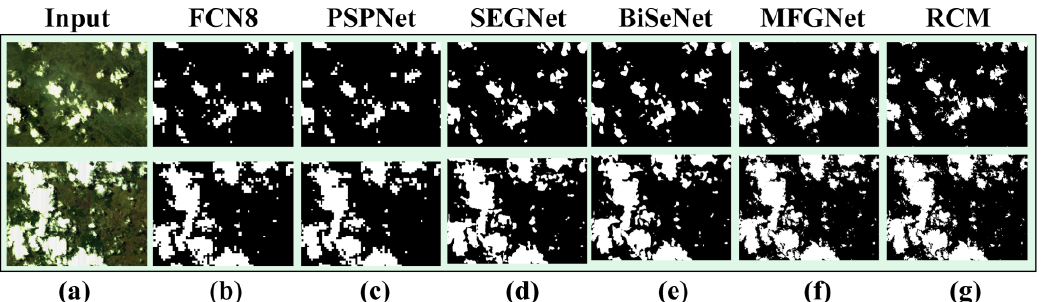
Figure 13. Detailed performance of different algorithms in cloud segmentation. ( a ) the GF-5 preview images. ( b )–( f ) are the prediction result of FCN8, PSPNet, SegNet, BiSeNet, and MFGNet. ( g ) the reference cloud mask.